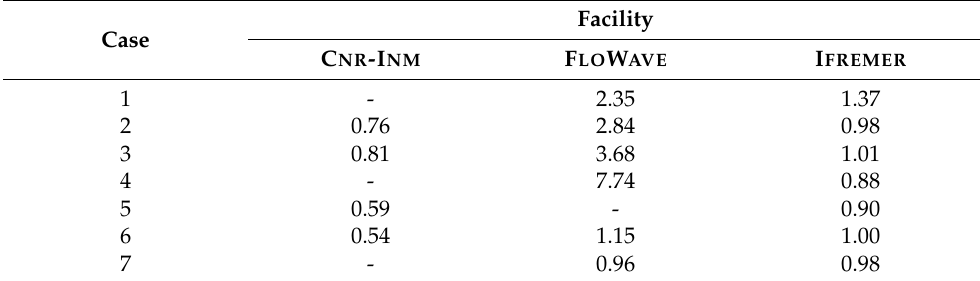
Table 11. Combined uncertainty for thrust as percentage of mean value based on the case number for each facility [%]. Current-only cases at C NR -I NM have no